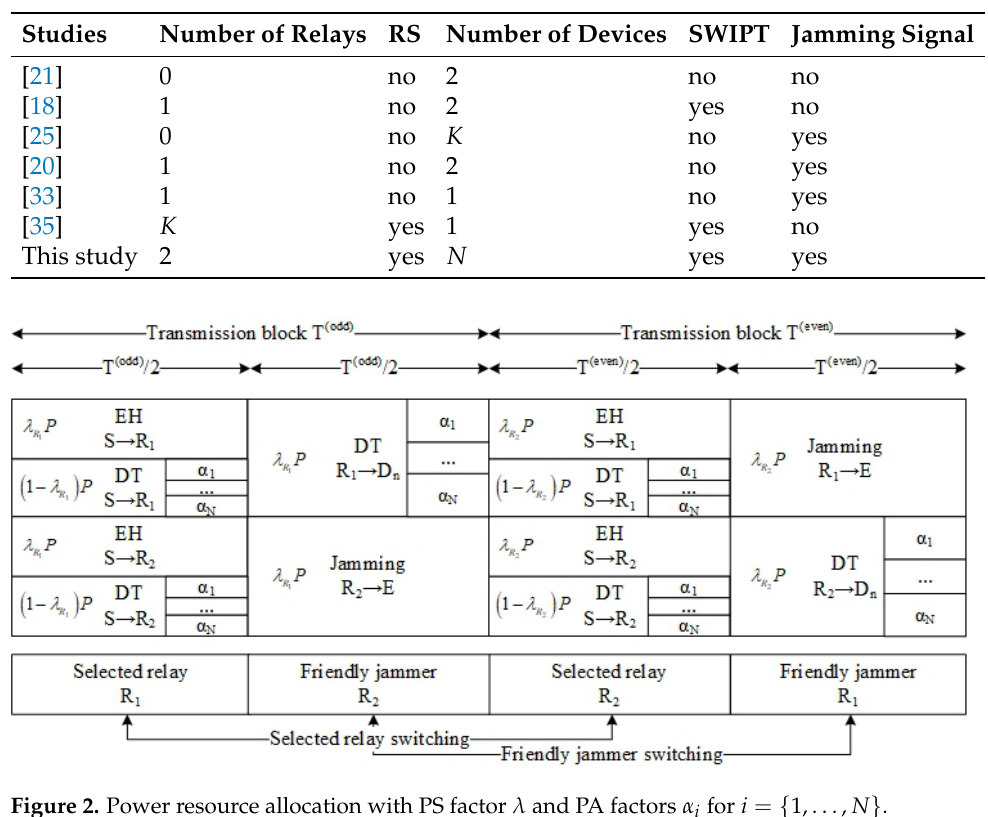
Figure 2. Power resource allocation with PS factor λ and PA factors α i for i = { 1, . . . , N }